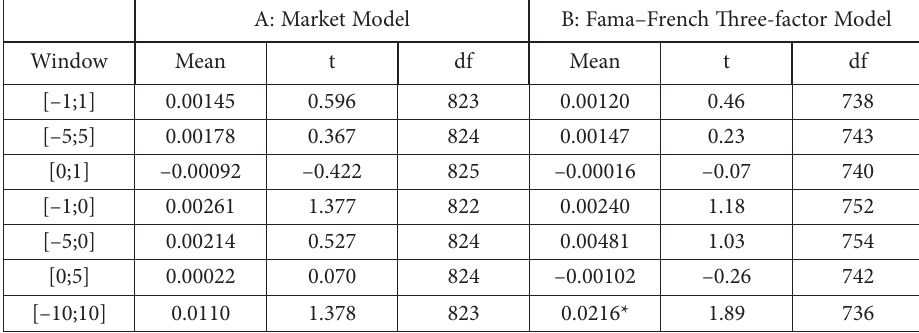
Table 6. Student’s t-test: difference between the food and automotive industries